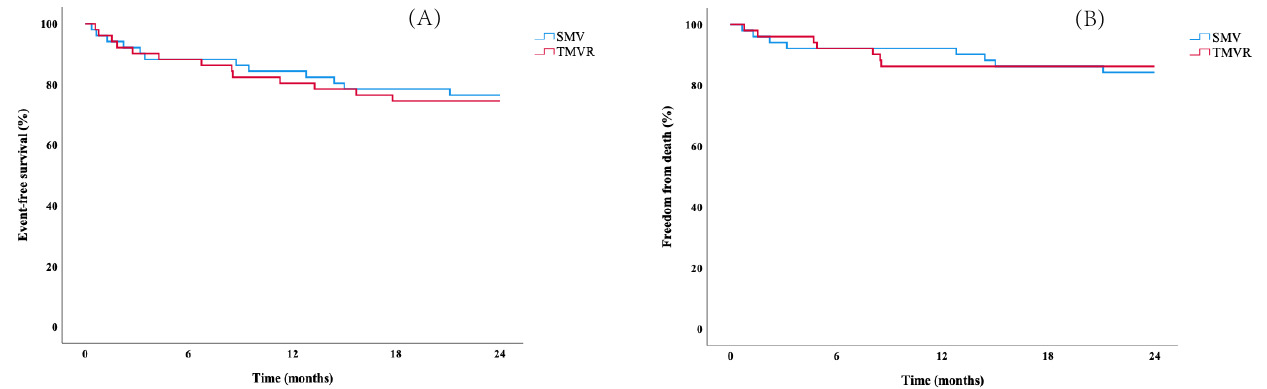
Figure 2. Kaplan-Meier curves stratified for type of intervention (surgical mitral valve treatment: SMV, transcatheter mitral valve repair: TMVR) regarding ( A ) the primary composite endpoint (heart failure hospitalization/death), and ( B ) all-cause death in the matched study population ( n = 102).